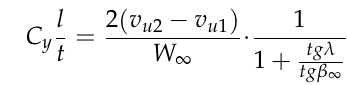
Figure 22. Velocity triangle of the rotor blade profile.